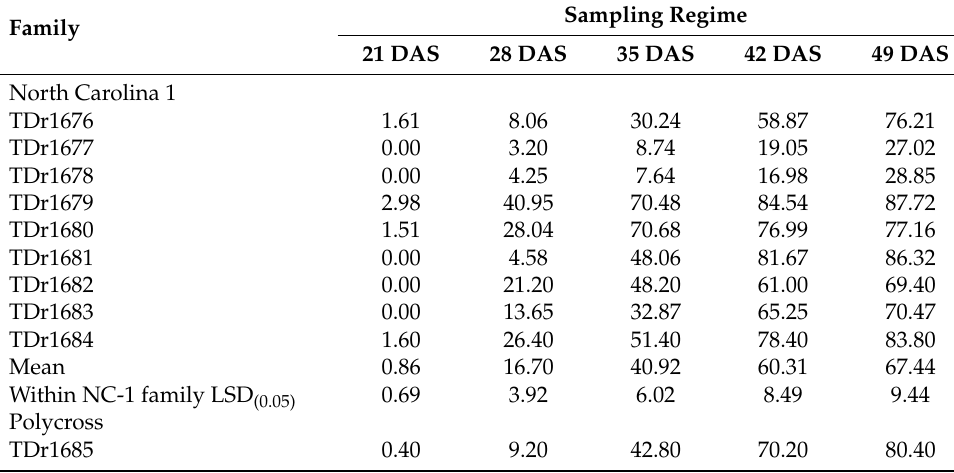
Table 3. Mean percent germination of yam botanical (true) seeds across families and sampling regimes.